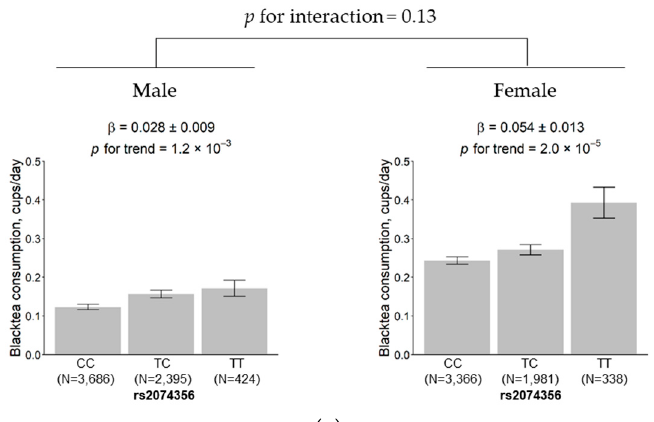
Figure 4. Effects of rs2074356 on habitual black tea consumption stratified by sex ( a ) and age ( b ). The black tea consumption is marked for each allele, CC, TC, and TT, for rs2074356. Error bars and ꞵ indicate the standard deviation and the estimated regression coefficient,